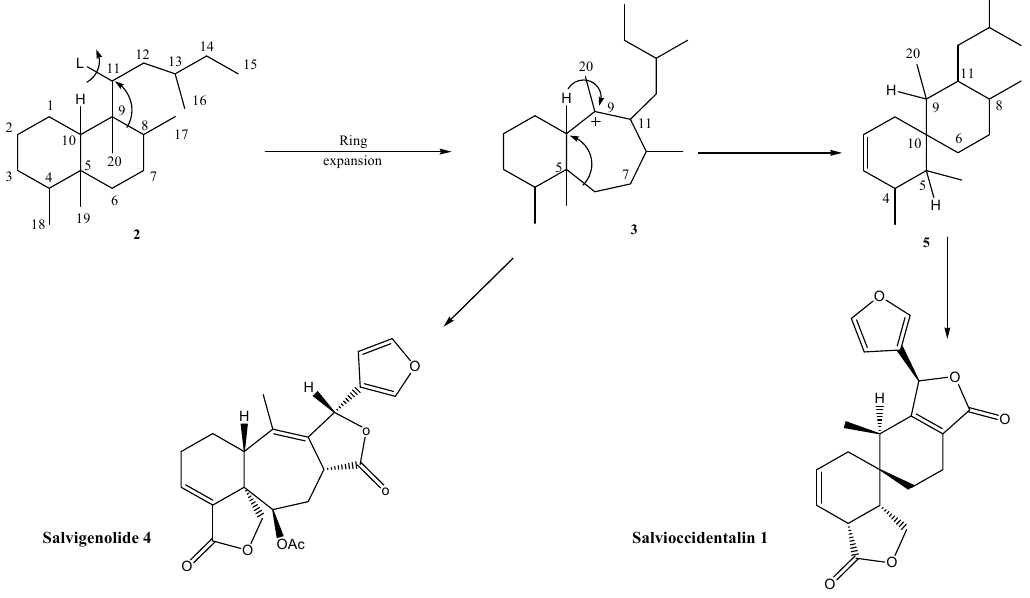
Scheme 1. Proposed biogenetic pathway for salvioccidentalin 1